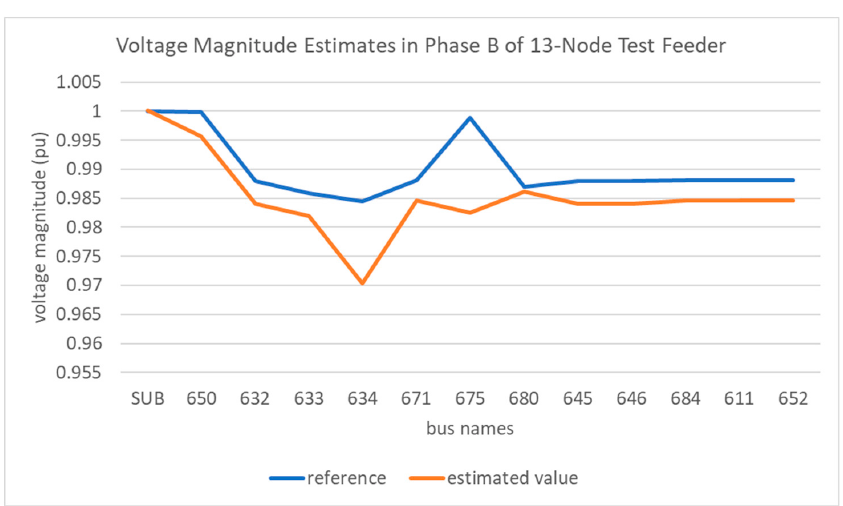
Figure 5. 13-bus feeder’s voltage magnitude estimates in phase B.